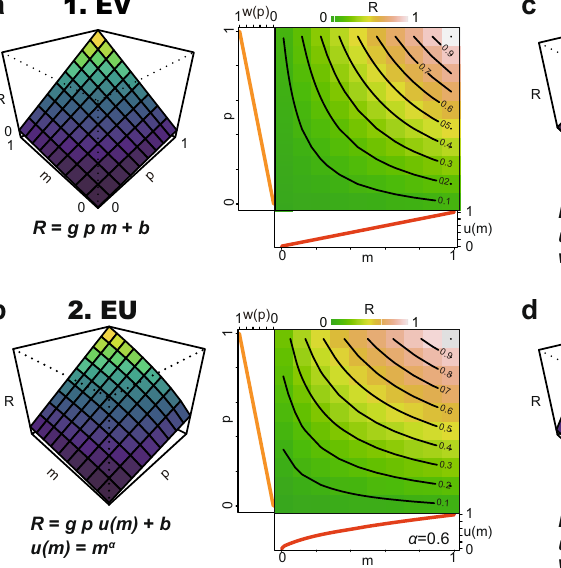
Fig. 3 | Neural models of economic decision theory. Schematic depiction of predicted neuronal responses R de fi ned by the four economic models that repre- sent the expected value ( a , EV), expected utility ( b , EU), prospect theory one- parameter Prelec ( c , PT1), and two-parameter Prelec ( d , PT2). Model equations are presentedineachplot. R wasplottedagainsttheprobability( p )andmagnitude( m ) of the rewards. b , g , α , γ , and δ are the free parameters. g and b are the gain and